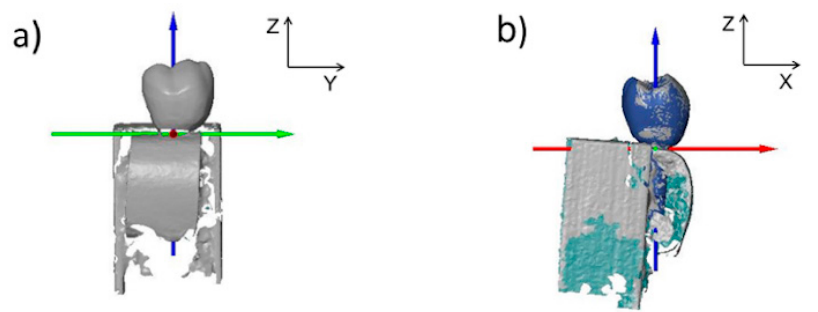
Figure 5. Acquisition of gold-standard values. Optical scan of porcine model ( a ) matched with the a priori information ( b ). The color shades at ( b ) are defined as follows: gray = outside surface; green = inside surface; and blue = a priori information.